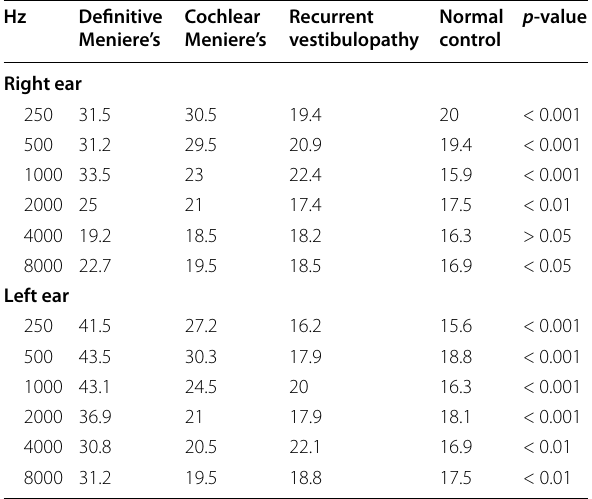
Table 5 PTA thresholds in different groups